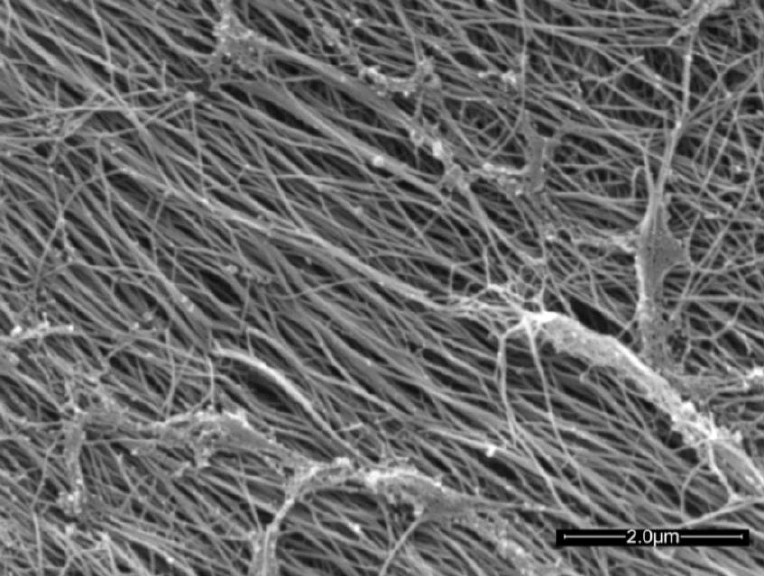
Figure 1. Scanning electron micrograph showing the high degree of collagen